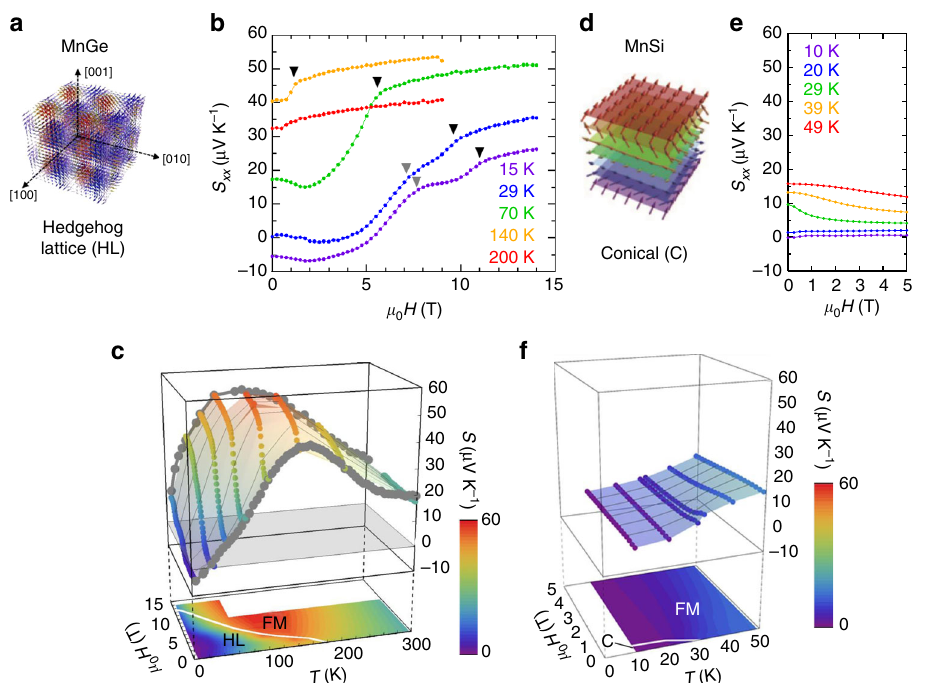
Fig. 1 Schematics of spin textures and magneto-thermopower in MnGe and MnSi. a Spin texture of MnGe which can be regarded as a periodic array of hedgehogs and anti-hedgehogs with a short magnetic period of 3 nm. They serve as quantized source (monopole) and sink (anti-monopole) of emergent magnetic fi eld, respectively. b Field-induced large magneto-thermopower observed in MnGe. Topological phase transition from hedgehog lattice to ferromagnetic state manifests itself as a kink in the S – H curve (shown as black triangles), suggestive of its link to the observed thermopower. There are also observed anomalies in the S – H curves at low temperatures, indicated by gray triangles. c Magneto-thermopower pro fi les for MnGe in the temperature – magnetic fi eld space. The contour mappings are displayed in the bottom plane with the white line representing the phase boundary between ferromagnetic (FM) state and hedgehog lattice (HL). d Conical spin texture (C) with a magnetic period of 18 nm in MnSi. e Magneto-thermopower in MnSi as the contrasting example to MnGe, which shows a monotonic decrease generically found in magnetic materials. f Magneto-thermopower pro fi les for MnSi in the temperature – magnetic fi eld